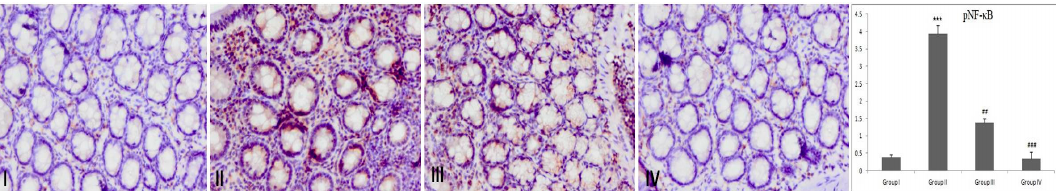
Figure 7. Effect of piperine treatment on pNF- κ B expression. Photomicrographs of colon sections Figure 7. E ff ect of piperine treatment on pNF- κ B expression. Photomicrographs of colon depicting immunohistochemical analyses; brown color indicates specific immunostaining of pNF- κ B and light blue color indicates counter-staining by hematoxylin. The colonic section of DMH-administered group-II has more pNF- κ B immunopositive staining, as indicated by brown color, as compared to control group I, while treatment of piperine (30 and 60 mg/kg b. wt.) in groups III and IV reduced pNF- κ B immunopositive staining as compared to group II ( n = 10). Piperine significantly downregulated pNF- κ B in group III and IV, respectively, ( ## p < 0.01) and ( ### p < 0.001),